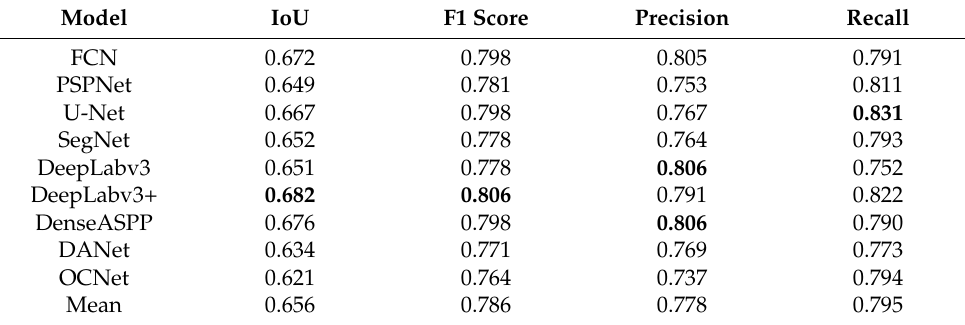
Table 2. Performance of different models using Dice